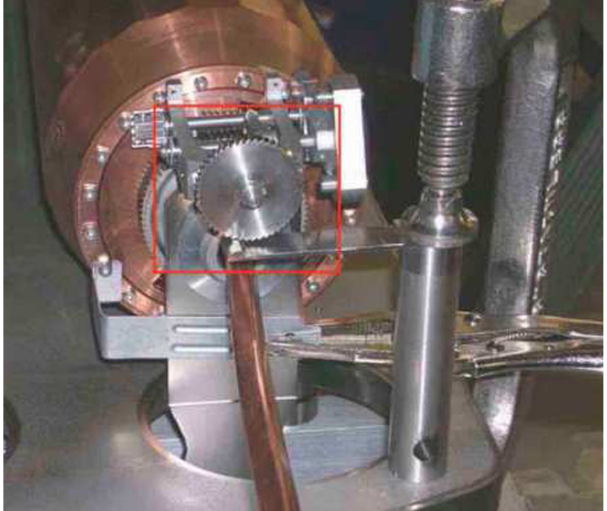
FIG. 2. View of the rotation mechanism (inside red box) attached to the jaw mounted on the base plate.